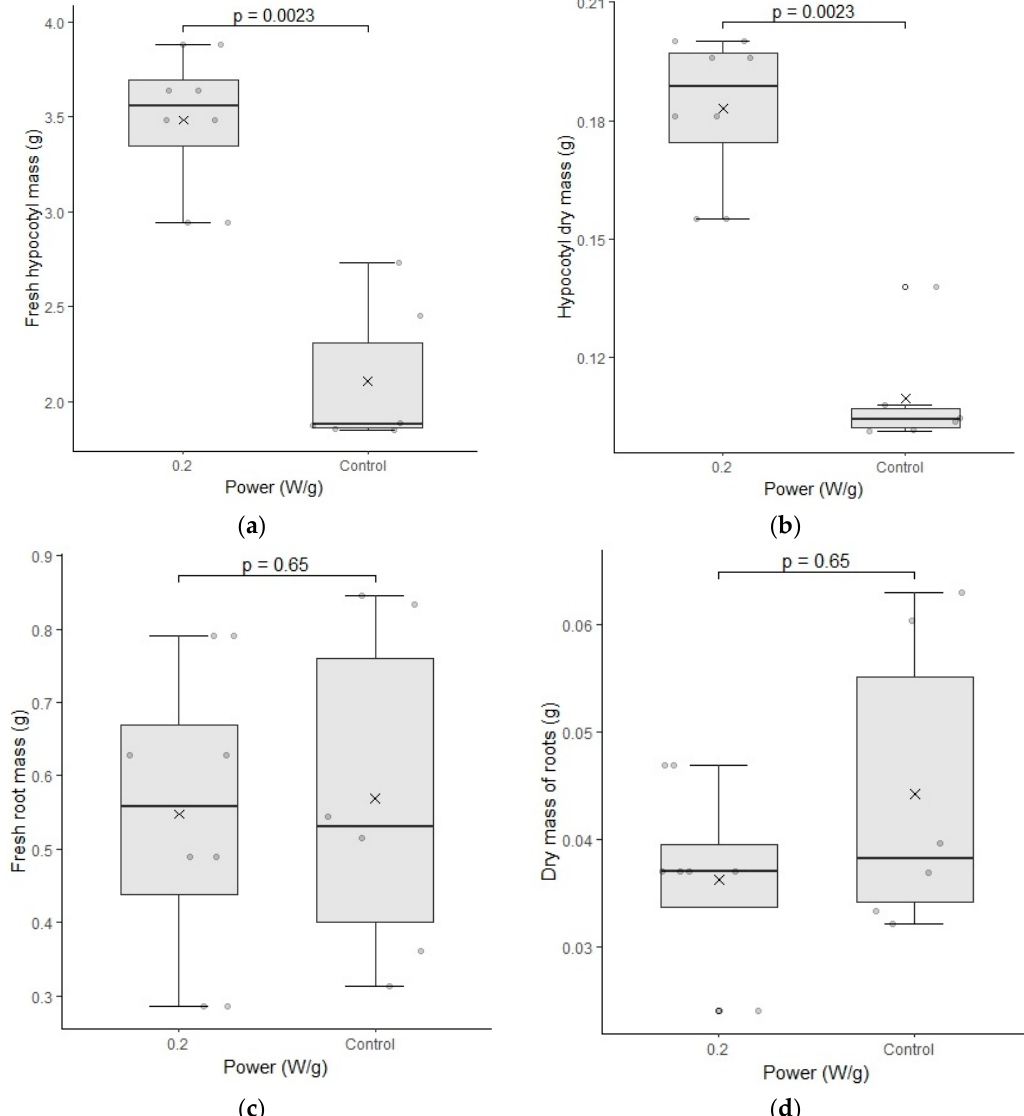
Figure 6. ( a – d ) represent the test of fresh mass and dry mass of cultivar C01. The differences were analyzed using the Mann–Whitney U test at a significance level of 0.05. The media, data, and p value are represented in the figures for the x, dots, and letter p , respectively.